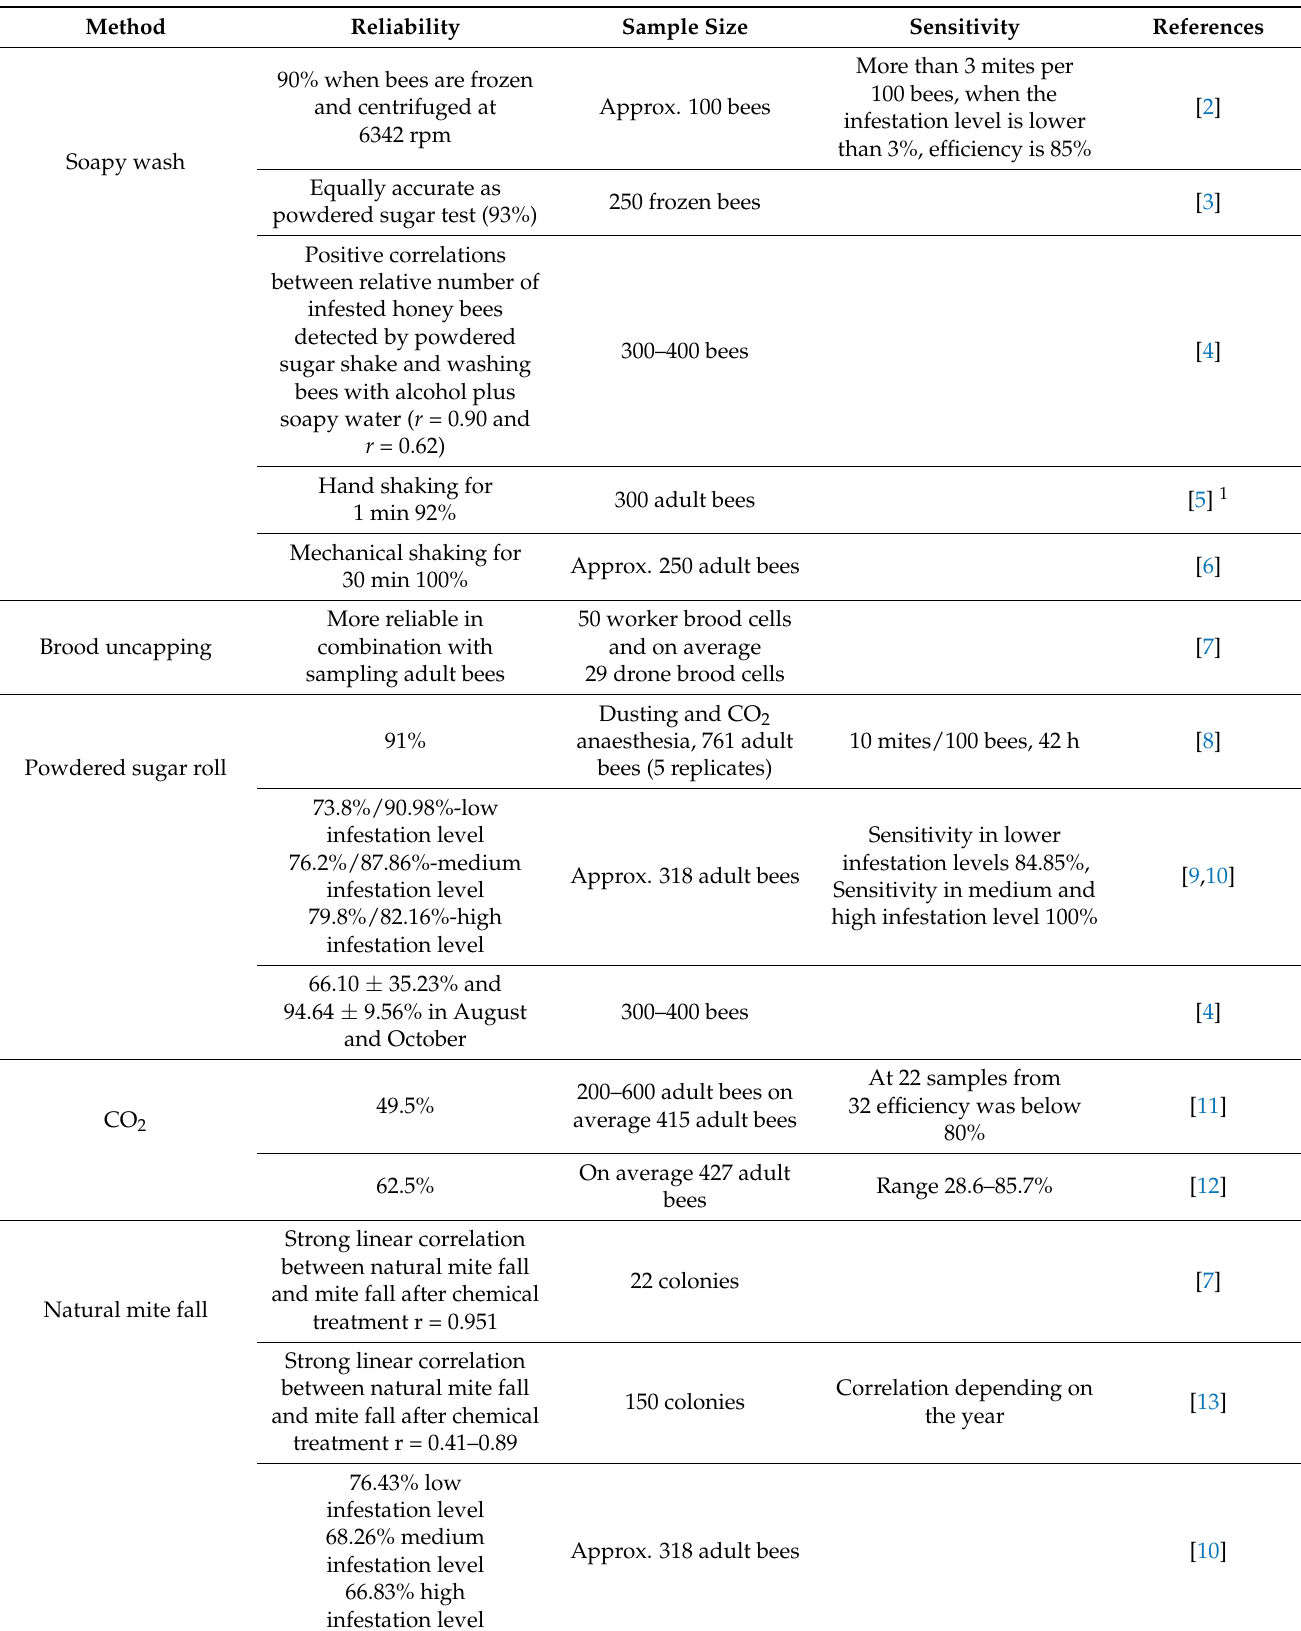
Table 1. Review of methods for varroa infestation level